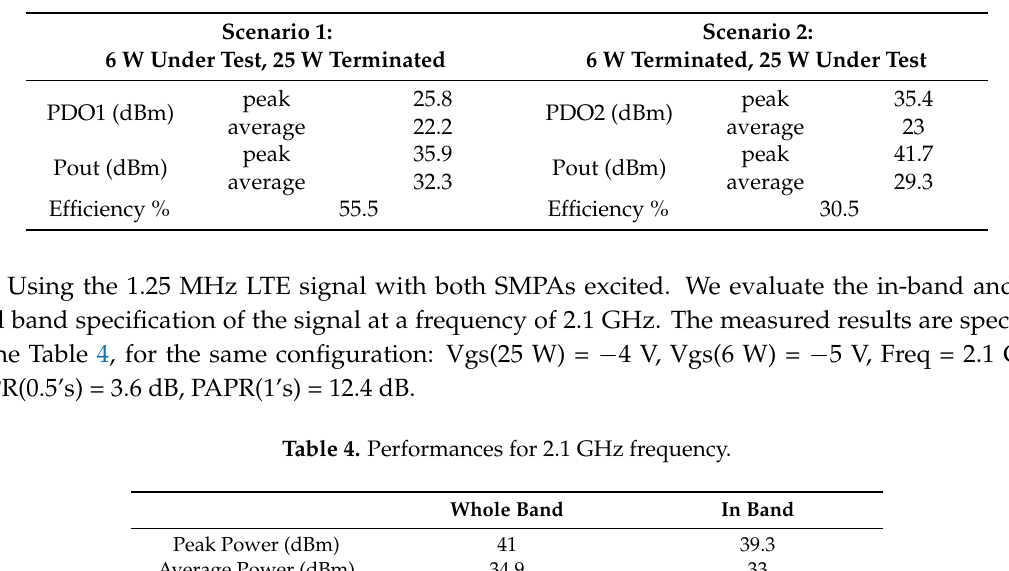
Table 3. LTE modulated signal tests.